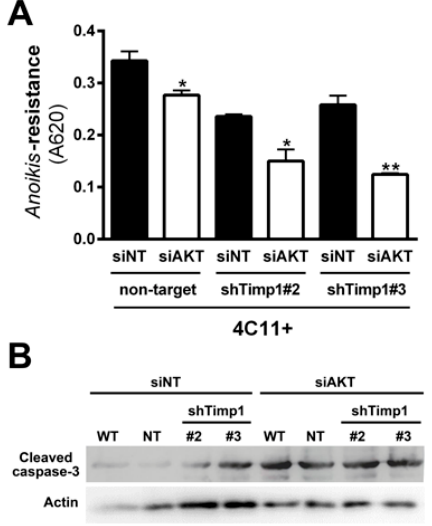
Figure 6. Simultaneous inhibition of Timp1 and AKT impairs more efficiently the survival of metastatic melanoma cells. The metastatic 4C11+ cell line silenced for Timp1 were silenced for AKT and analyzed for their capacity to survive ( A ) and induce caspase-3 cleavage ( B ); WT: non-treated cells; non-target (NT): control non-target shRNA; shTimp1#2: clone 2 silenced for Timp1; shTimp1#3: clone 3 silenced for Timp1. siNT: non-target siRNA; siAKT: siRNA specific for AKT. β -actin (Actin) was used as loading control. * p < 0.05, ** p < 0.01.